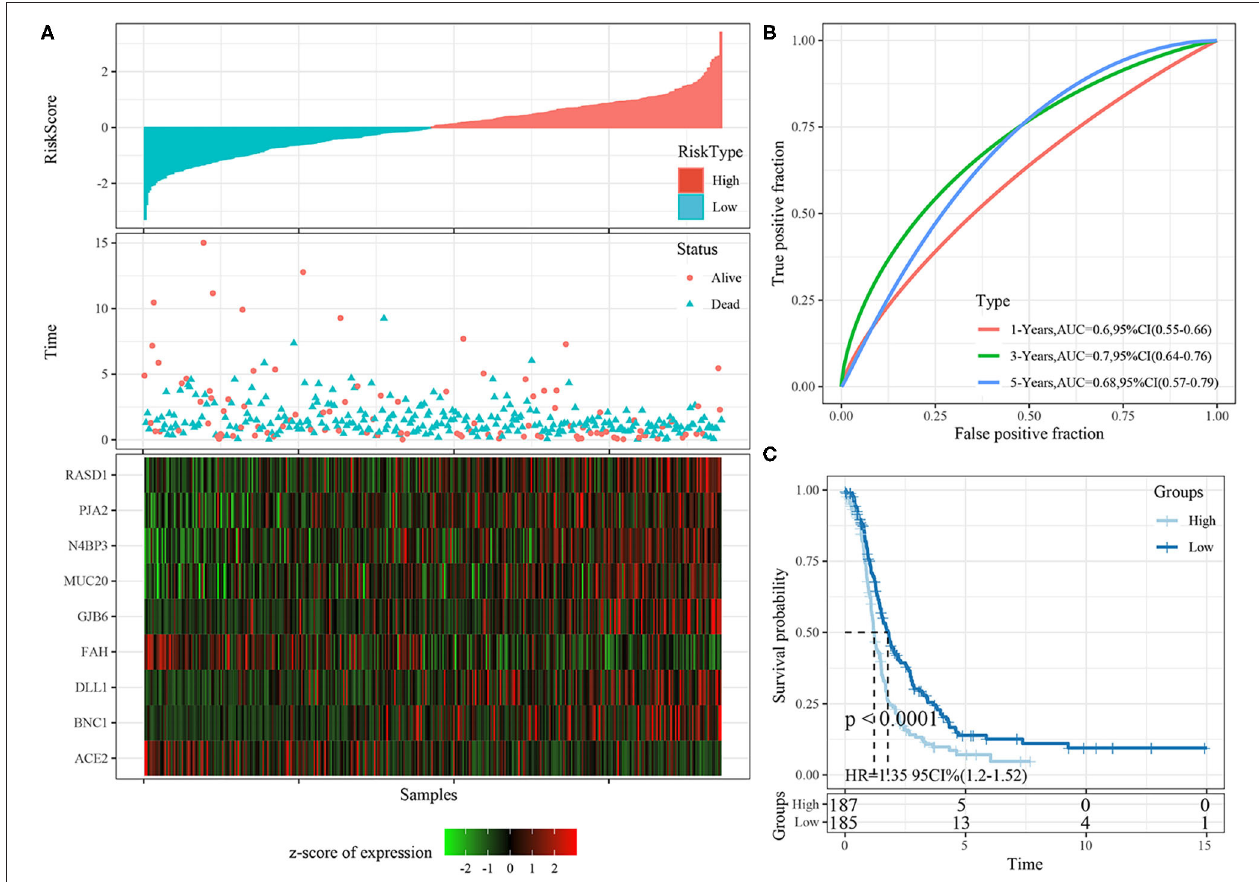
FIGURE 9 | (A) The distribution of risk score, survival time, and the expression of 9-gene in TCGA-OV cohort; (B) The ROC curve and AUC curve of 9-gene signature in TCGA-OV cohort; (C) The KM survival curve of 9-gene signature in TCGA-OV